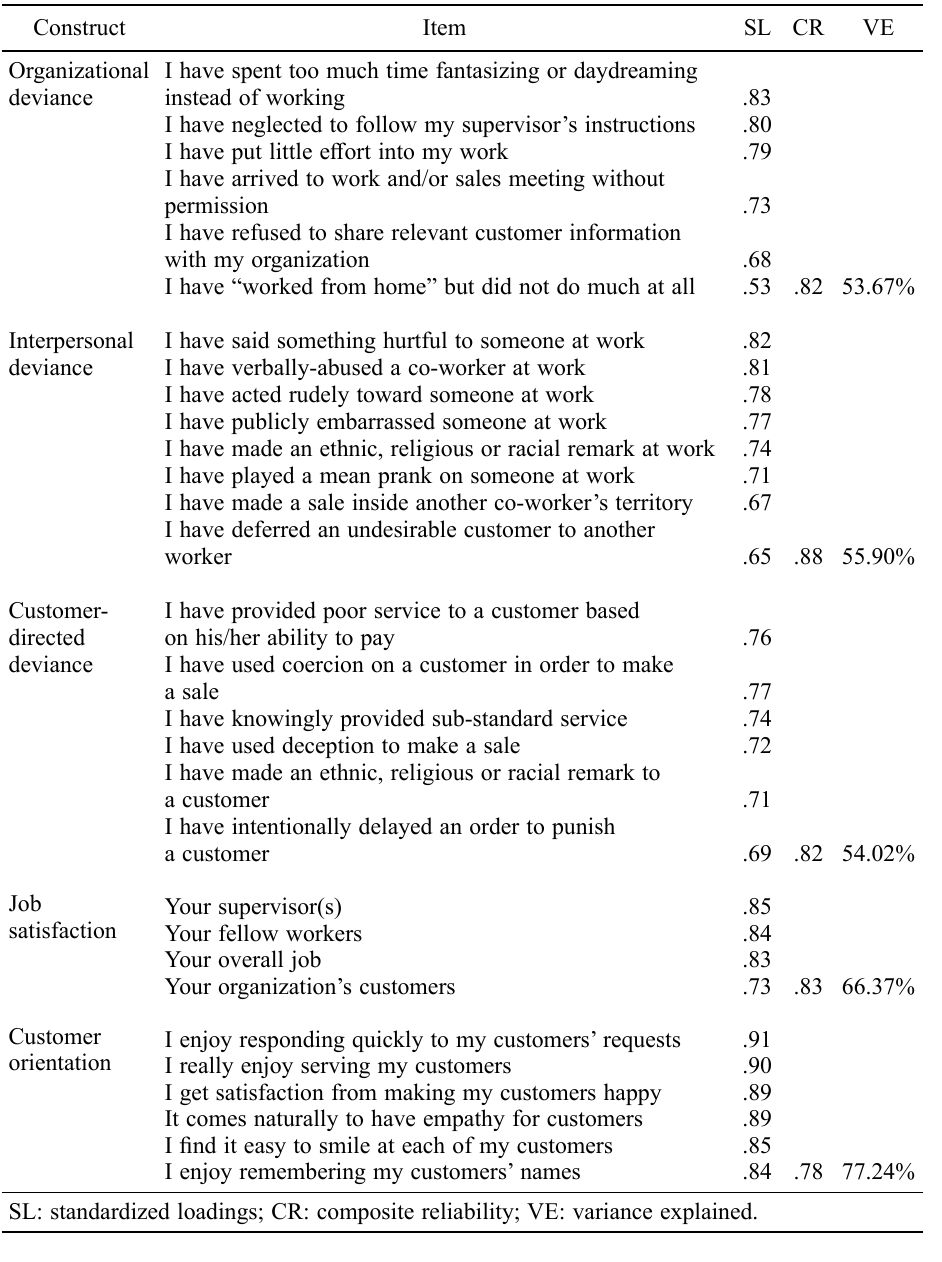
Table 2. Preliminary analysis of